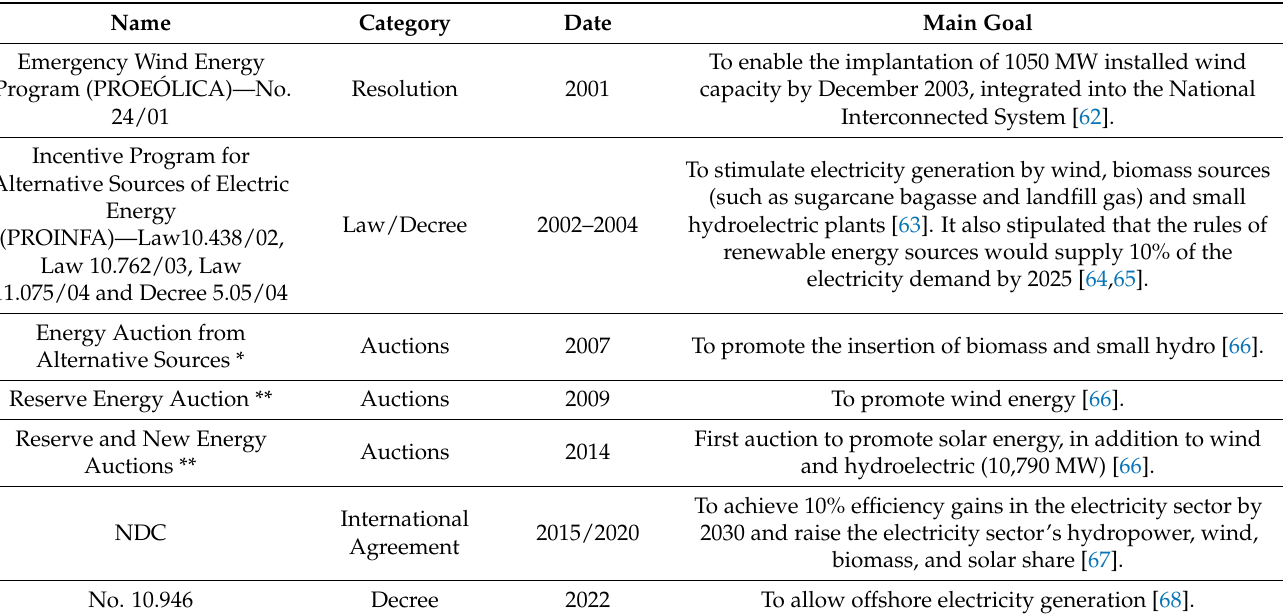
Table 3. Main government incentives for the entry of renewable energy into Brazil’s electricity sector